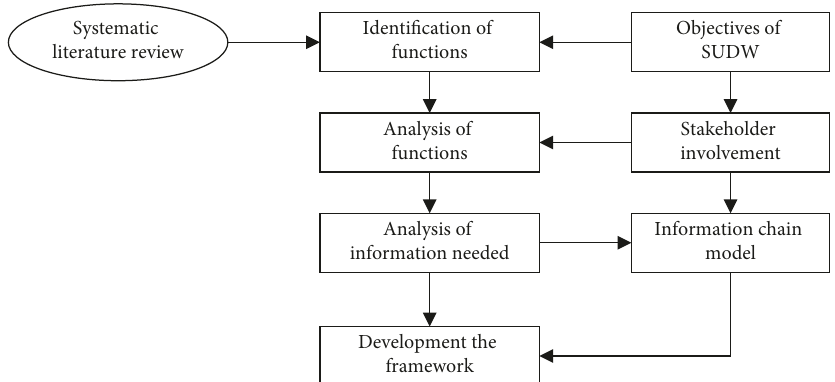
Figure 1: Process for developing the SUDW